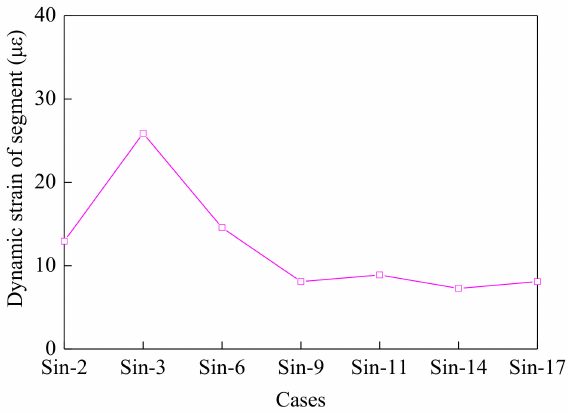
Figure 28. Maximum dynamic strain of segments under different